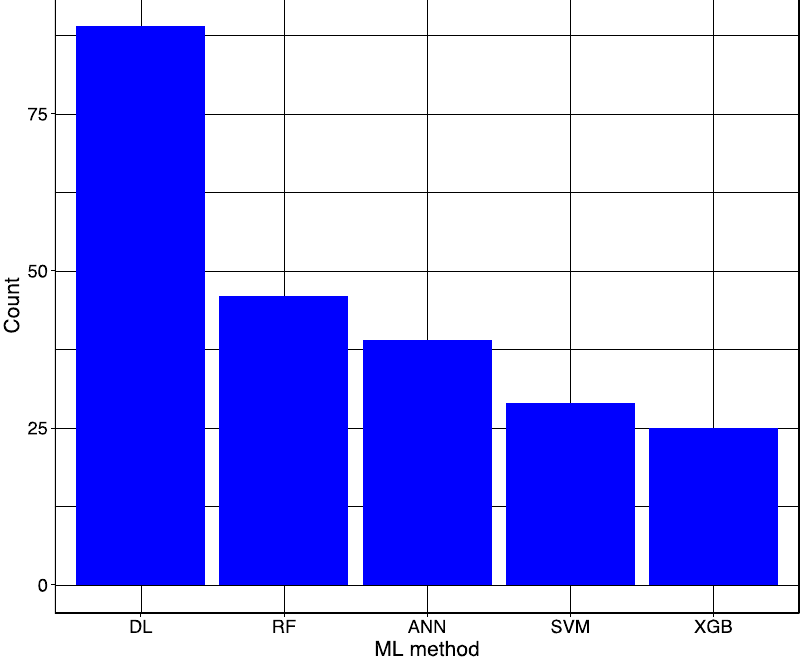
Figure 5. Most common methods in NWP-related articles.